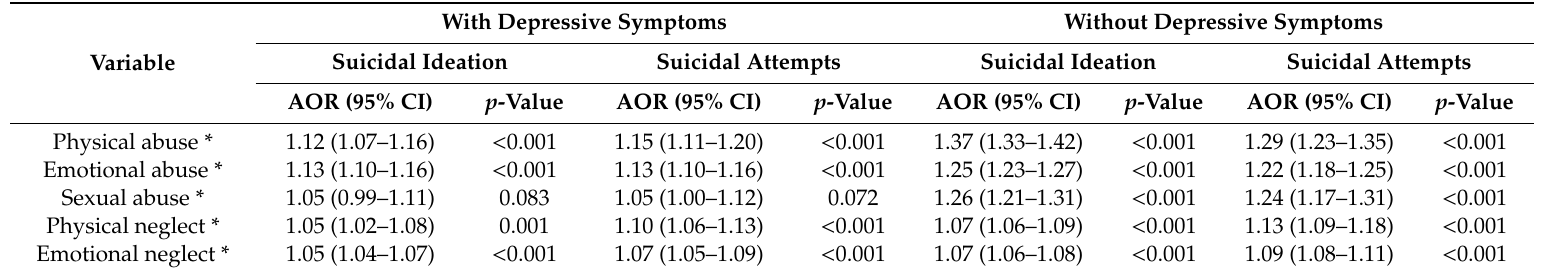
Table 4. Associations of childhood maltreatment and suicidality stratified by depressive